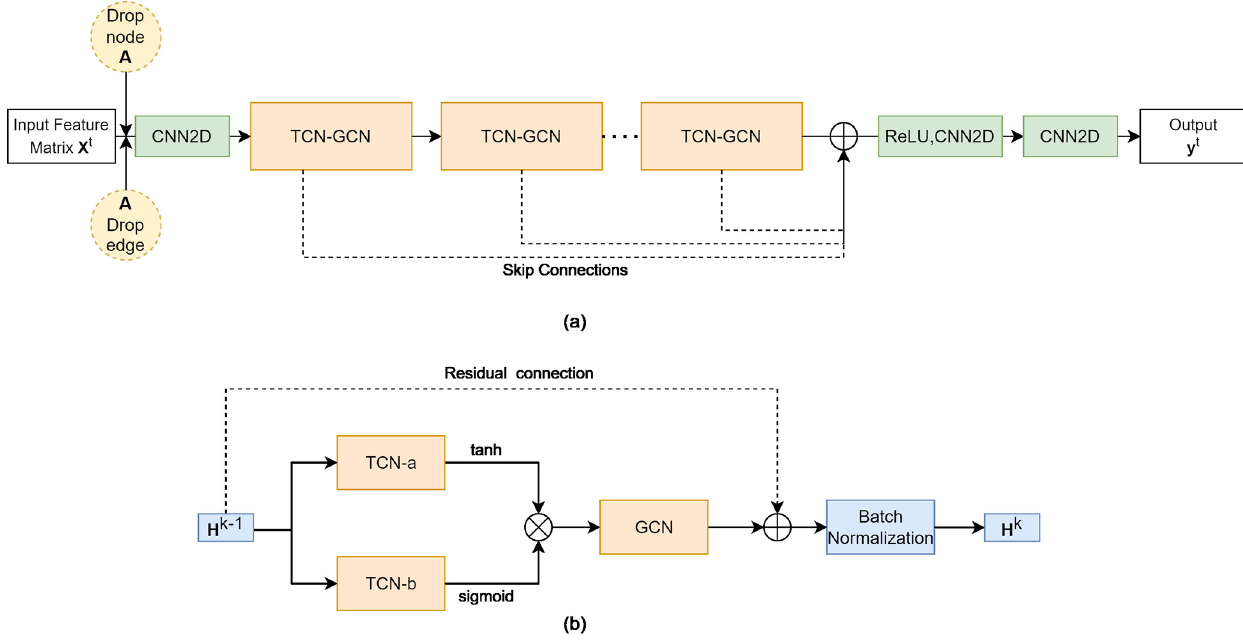
Figure 2. (a) GraphWavenet used in this work consists of a number of temporal convolution network and graph convolution network (TCN– GCN) modules for progressively encoding input data x t ; the outputs of each TCN–GCN are skip-connected to improve learning; 1 × 1 kernel convolutional neural network (CNN) layers are used as linear transformation layers; optionally, nodes and edges in the adjacency matrix A are randomly masked for improving training and for graph coarsening (i.e., DropNode and DropEdge); (b) the internal design of each TCN–GCN module, which consists of interleaved TCN and GCN layers to process information from one hidden layer to the next. The layer input and output are connected via residual connections to improve